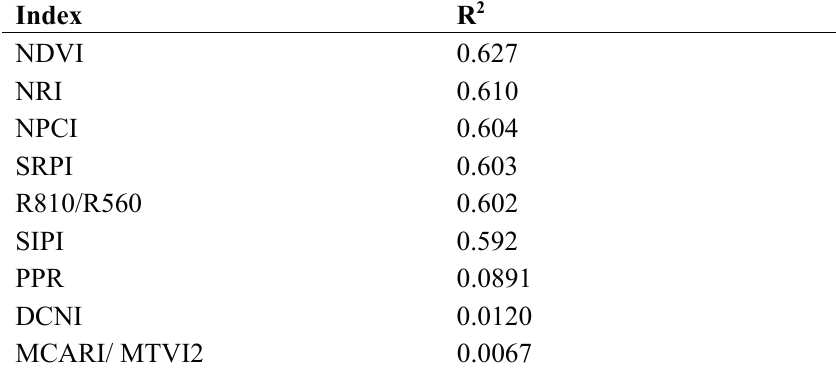
Table 2. Coefficients of determination (R 2 ) between foliage total nitrogen density and vegetation indices at VZAs of